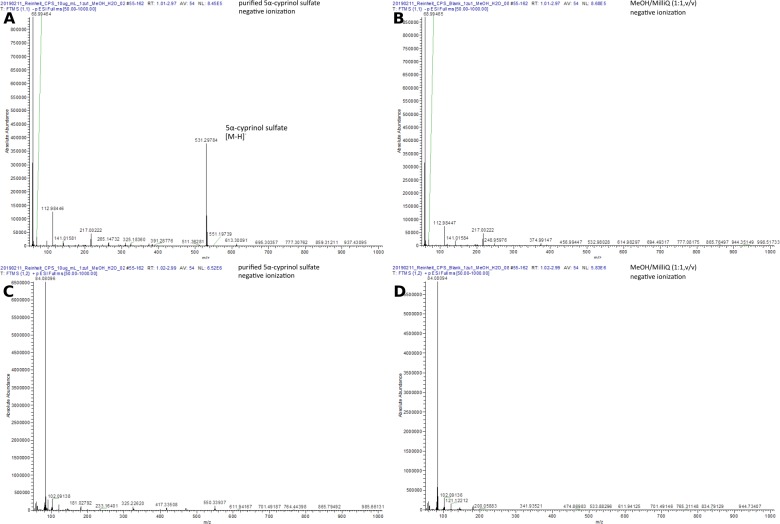
MS data of the subfraction from 1 to 3 min of LC-MS runs of purified 5α-cyprinol sulfate (α-CPS) and a blank sample (SI Figure 4).ESI-MS spectra extracted from the time window of 1–3 min in SI Figure 4. Obtained spectra for α-CPS (A, B) and blank measurements (MeOH/MilliQ, 1:1, v:/; C,D) measured either after negative or positive ionization.